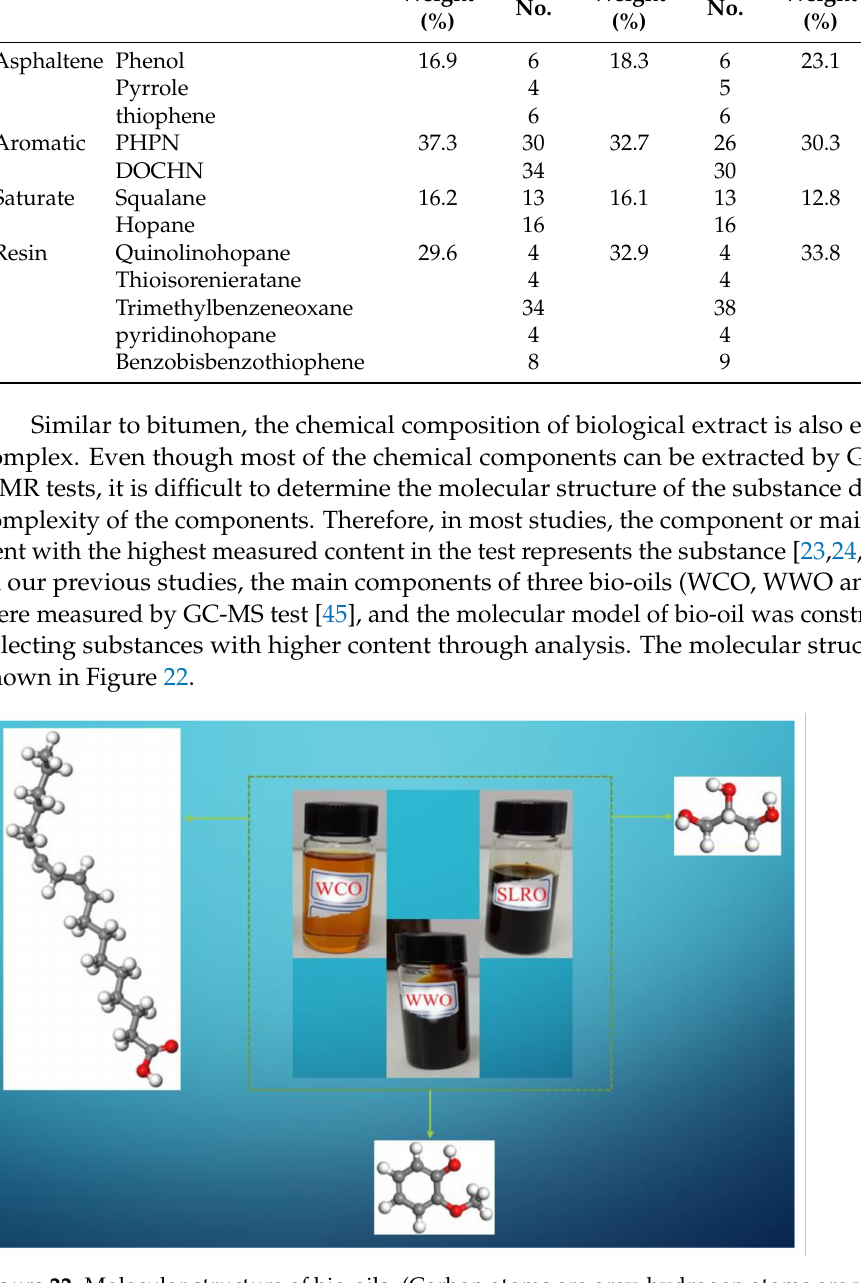
Figure 22. Molecular structure of bio-oils. (Carbon atoms are grey, hydrogen atoms are white, and oxygen atoms are